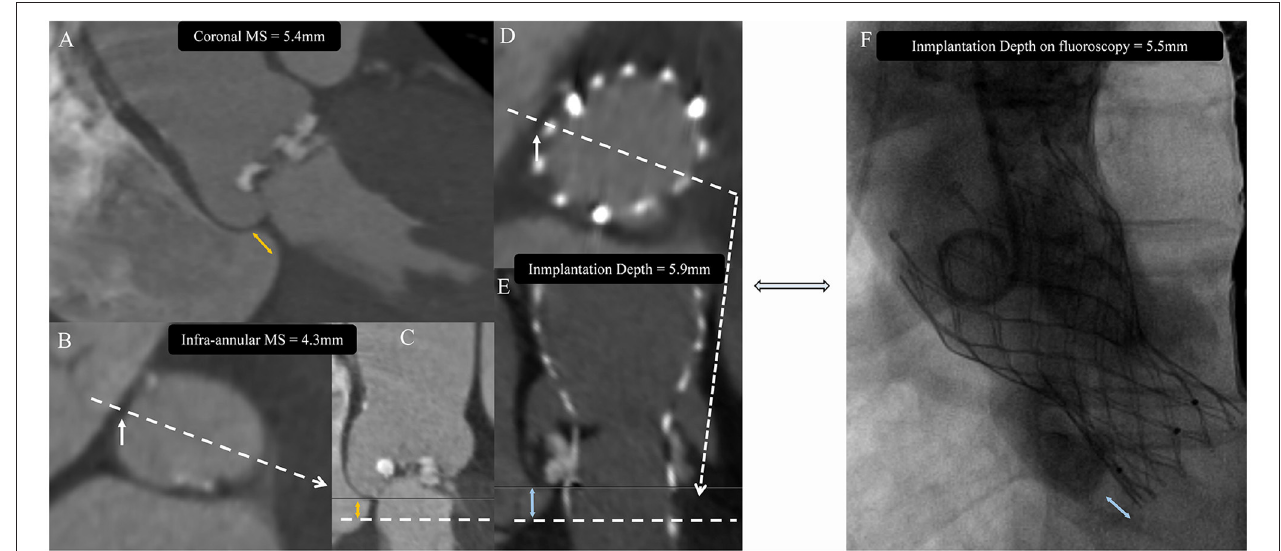
FIGURE 2 | Image analysis protocol. The membranous septum (MS) was measured on coronal view (A) as coronal MS or on stretched vessel view (C) as infra-annular MS at the tricuspid insertion point (B) . Device’s implantation depth (ID) was measured on post-operative CT (D,E) and was compared with the measurement on post-releasing fluoroscopy (F) . Yellow double arrow indicates membranous septum length (MS). White arrow indicates tricuspid insertion point. Blue double arrow indicates prosthesis implantation depth